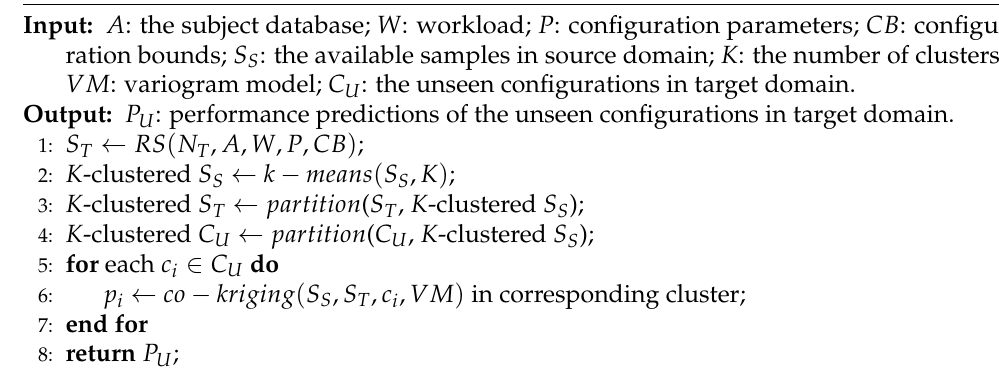
Algorithm 1 PCK ( A , W , P , CB , S S , K , VM , C U )